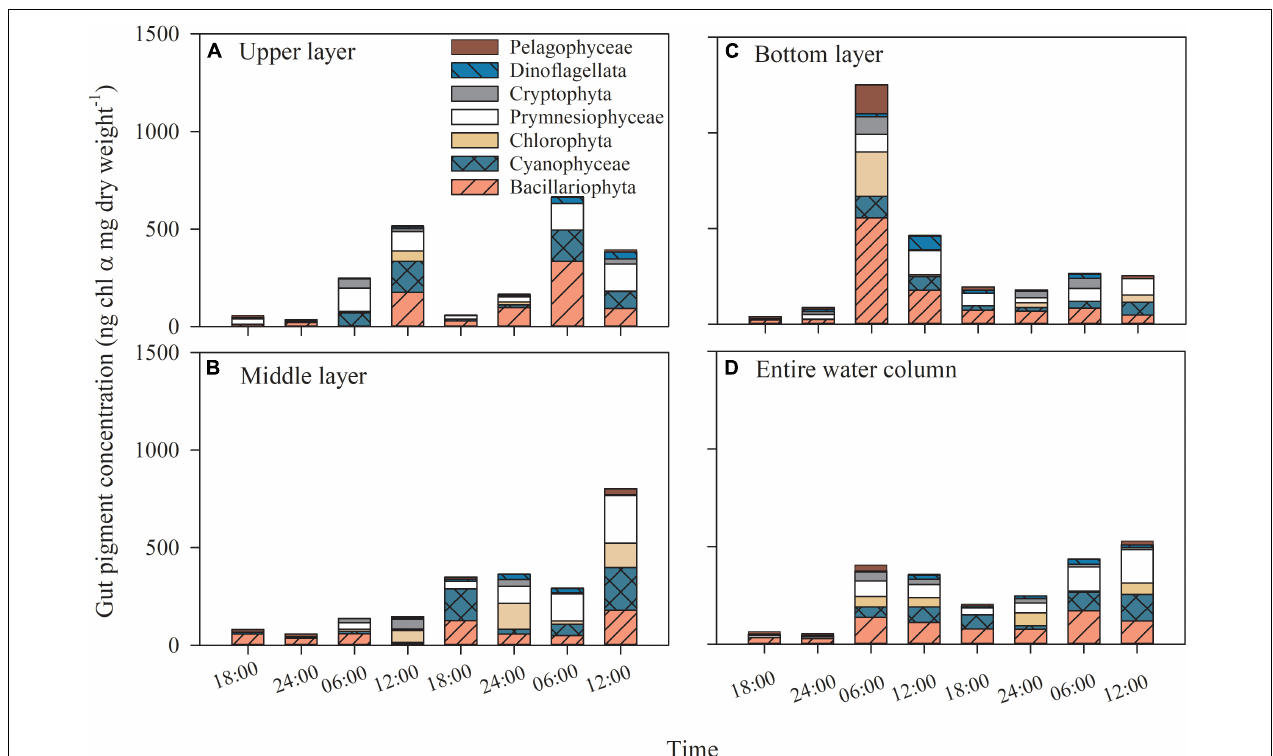
FIGURE 6 | Dial variation in gut pigment contents and the contributions of phytoplankton groups to gut pigments in the (A) upper layer, (B) middle layer, (C) bottom layer, (D) entire water column of Daya Bay during September 30 to October 2, 2014.